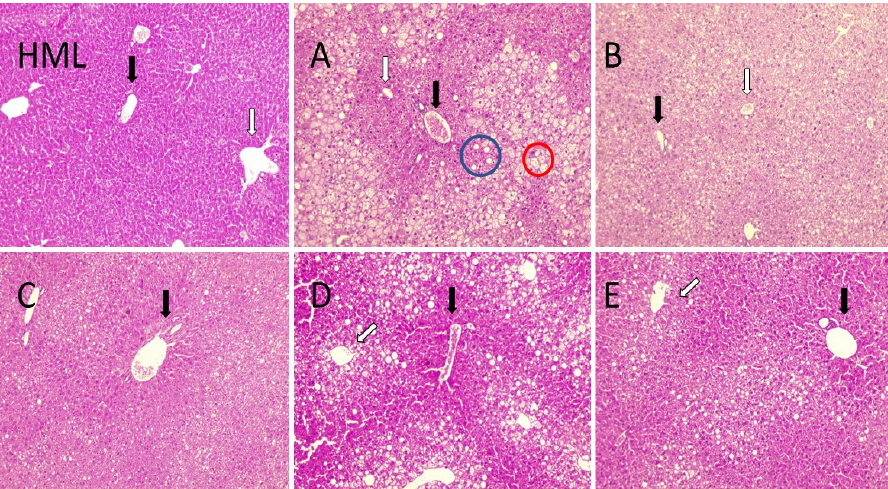
Figure 5. Effects of sPAG treatment on liver markers in obese mice. ( a ) glutamate–pyruvate transaminase; ( b ) alkaline phosphatase; ( c ) glutamic oxaloacetic transaminase ( d ) liver weight. Treatments were as follows: Group A, sunflower oil; group B, gallic acid; C, DRCSO; D, sAG and E, sPAG. Mice were fasted for 6 h before euthanasia (n = 6–8). Data are expressed as mean ± standard error of the mean (S.E.M.). Statistical differences were determined using one-way ANOVA, fol- lowed by Tukey’s post hoc test: * p < 0.05.